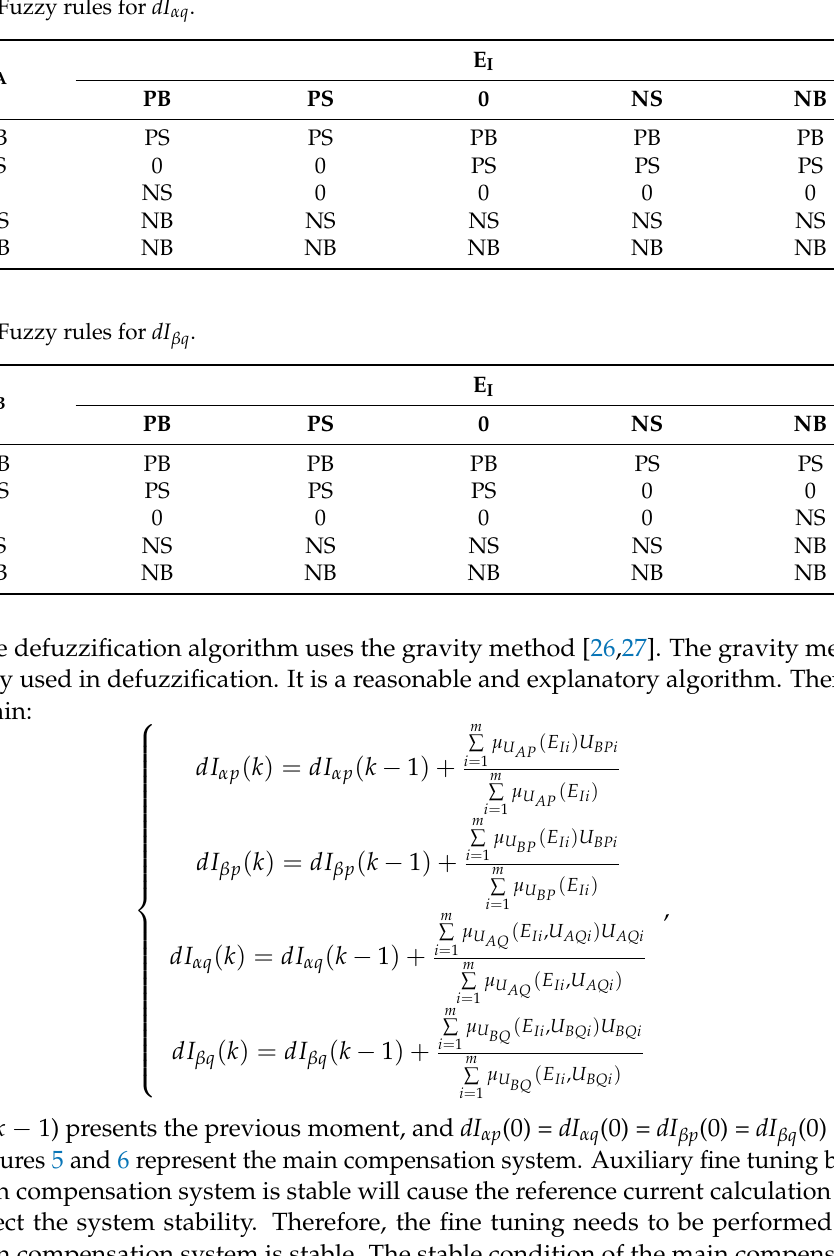
Table 2. Fuzzy rules for dI α q .